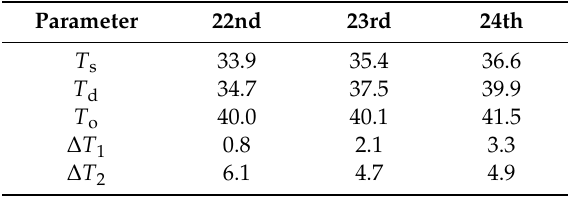
Table 8. Peak temperature comparison under Strategy 2.